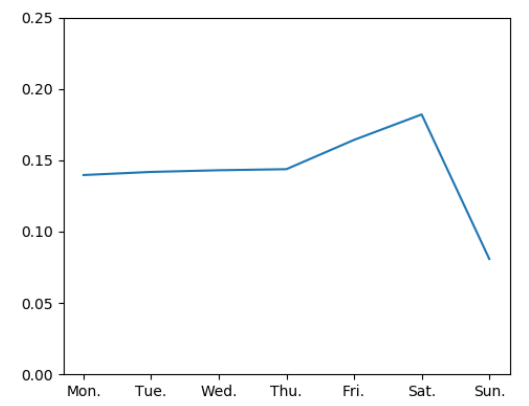
Figure 9. Weekly pattern of R agg estimated with the C/SimpleT method. The plot shows the values of R agg averaged per day of the week, normalised to sum to 1.